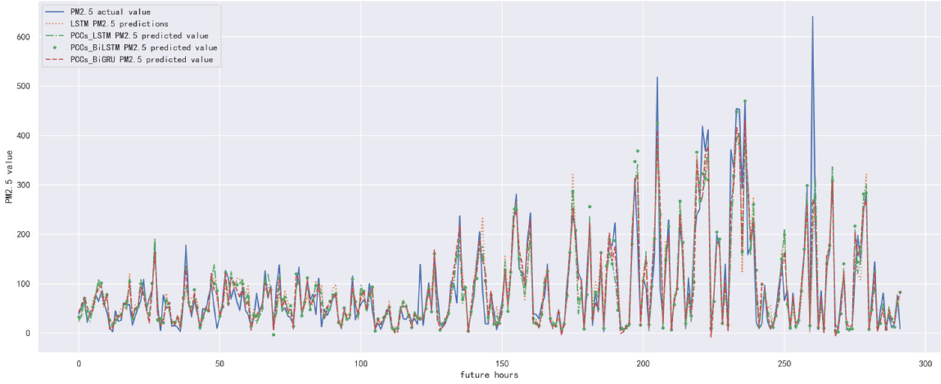
Figure 12. The schematic diagram of predicted PM 2.5 concentration in the next three hours.